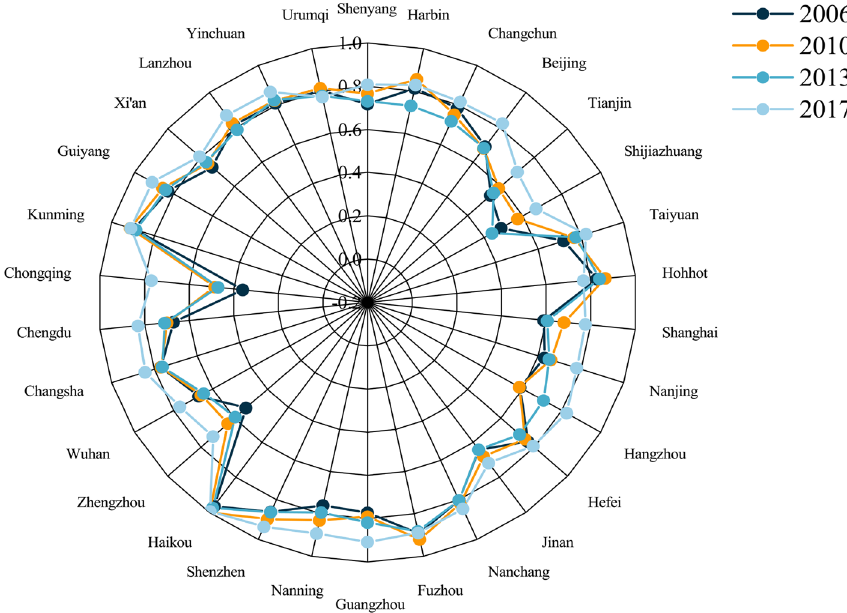
Figure 5. Trend of the environmental index in typical cities in